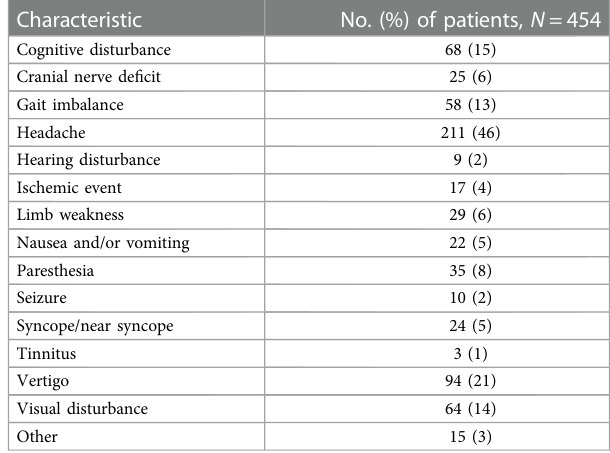
TABLE 1 Patient demographics and aneurysm characteristics among 454 patients with unruptured intracranial aneurysms. Characteristic